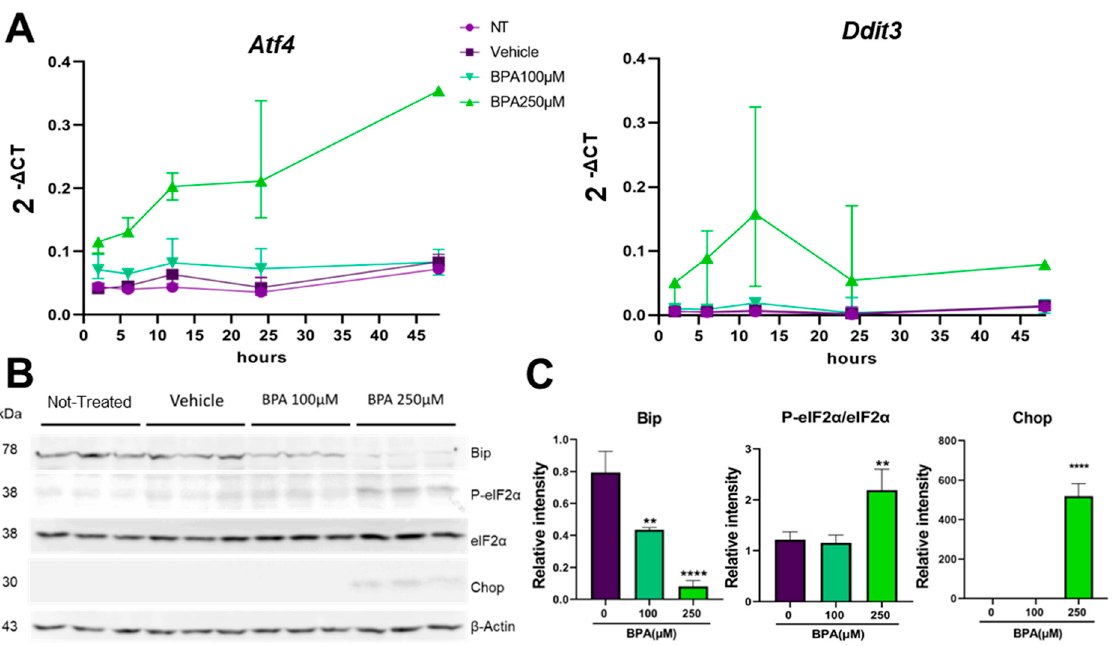
Figure 4. BPA determines the increased expression of pro-apoptotic UPR elements. ( A ) Time course of BPA-induced gene expression of Atf4 and Ddit3 in MIN6 cells. The 2 – Δ CT values were calculated by normalization to Gapdh . ( B ) MIN6 cells were treated for 8 h with BPA (100 or 250 µM). Whole-cell lysates were analyzed by Western blot for GRP78 (Bip), P-eIF2 α , total eIF2 α , Chop and β -Actin. ( C ) Graphs depicting quantifications of the immunoblots where the values were first normalized to β -Actin and then to the values of the untreated group. ** p < 0.005, **** p < 0.0001 compared to the vehicle by One-way ANOVA. Graphs represent the mean ± SD.